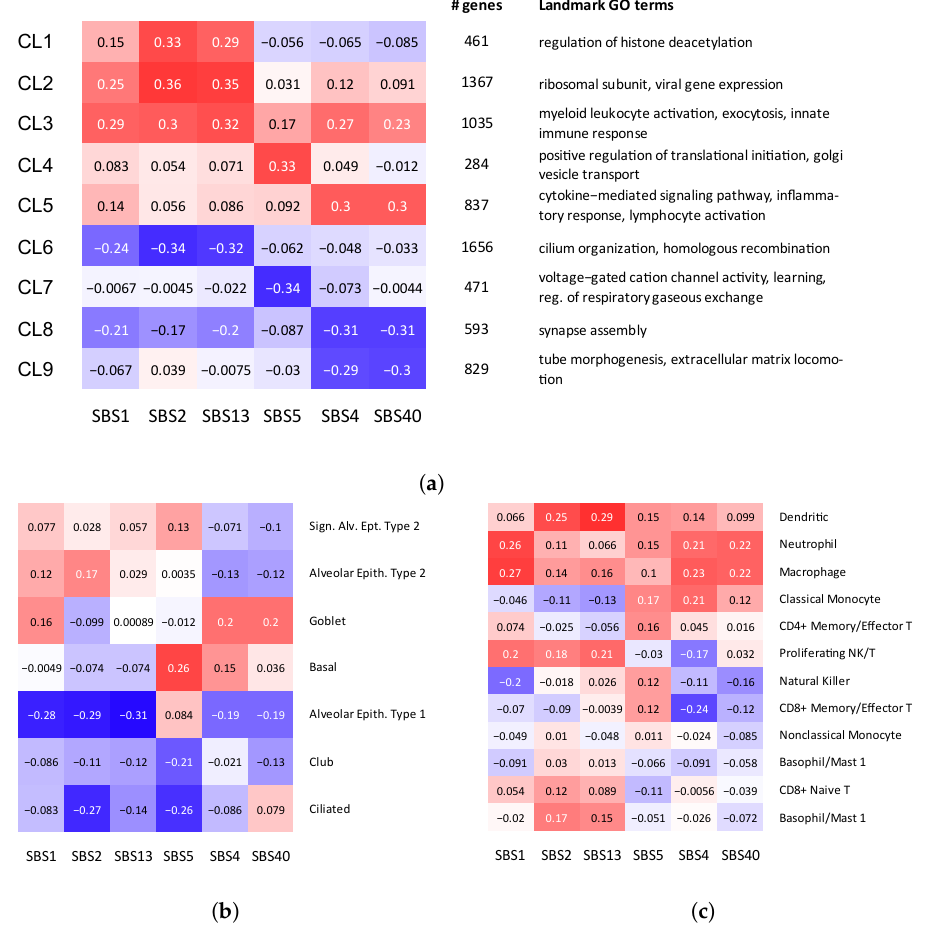
Figure 2. Correlation between mutational signatures and cell type composition and gene expression. ( a ) ECoSigClust clusters, based on the correlation between mutational signatures and gene expression. Genes having a significant correlation with at least one mutational signature ( p < 0.05) are included in the clustering. The heat map shows the mean correlation between signature and expression among all genes in the cluster (left). For each cluster, the number of genes and representative GO terms enriched in the cluster genes are also shown. ( b , c ) Correlation between mutational signatures and cell composition. Bulk expression counts are decomposed into different cell types using CIBERSORTx, and Spearman correlation coefficients are shown for ( b ) epithelial cells and ( c ) immune cells,